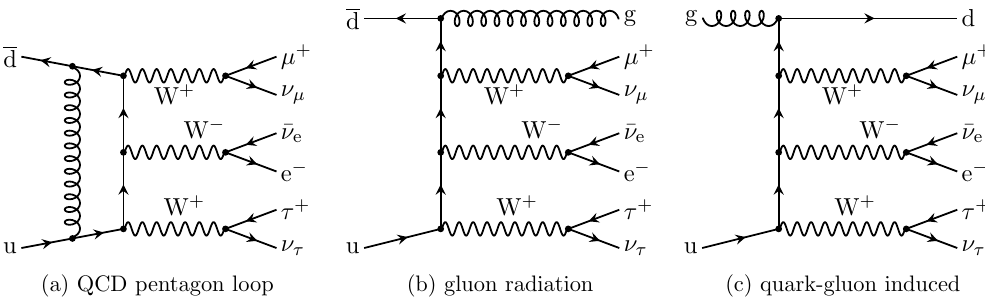
Figure 2. Selection of NLO QCD Feynman diagrams contributing to pp ! e (cid:0) (cid:22) (cid:23) e (cid:22) + (cid:23) (cid:22) (cid:28) + (cid:23) (cid:28) + X .